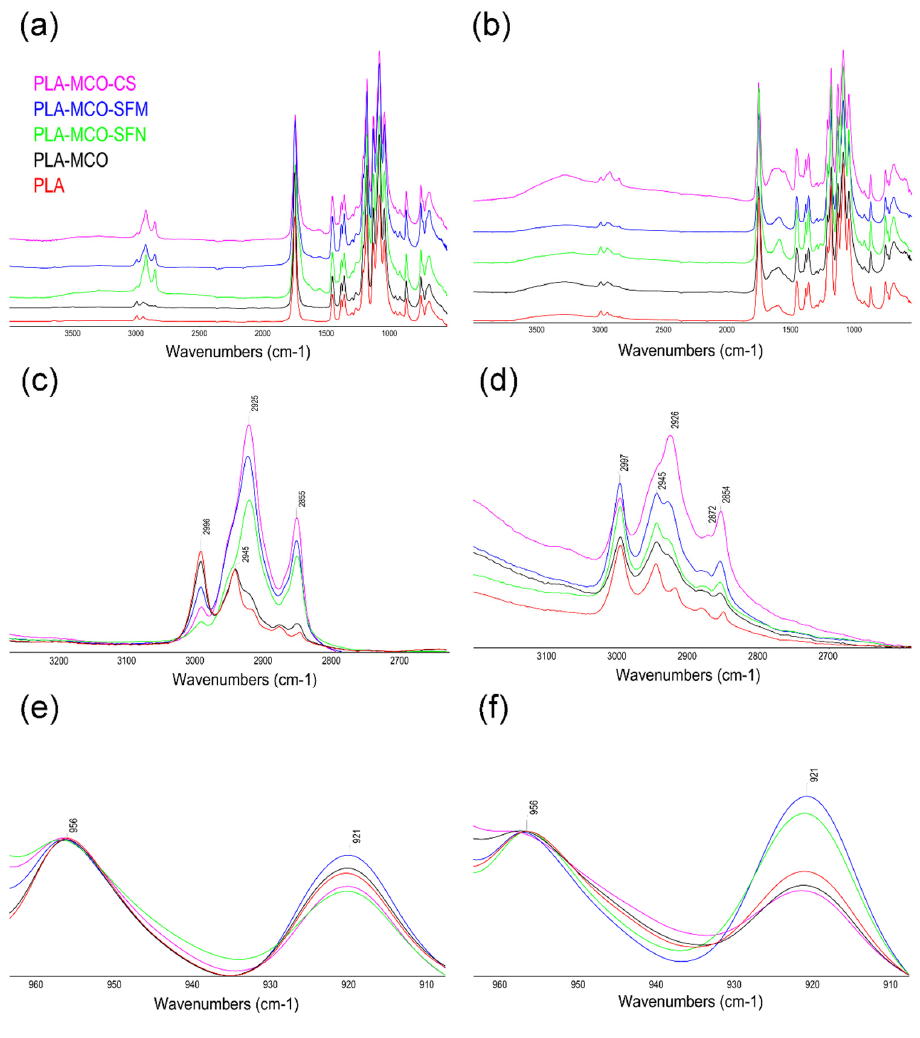
Figure 10. Comparative evolution of the ATR-FTIR spectra along the incubation at composting conditions: Full spectra of the composites at days 1 ( a ) and 30 ( b ). Detail of the spectral region 3200–2700 cm − 1 , at days 1 ( c ) and 30 ( d ). Detail of the spectral region 960–910 cm − 1 , at days 1 ( e ) and 30 ( f ).